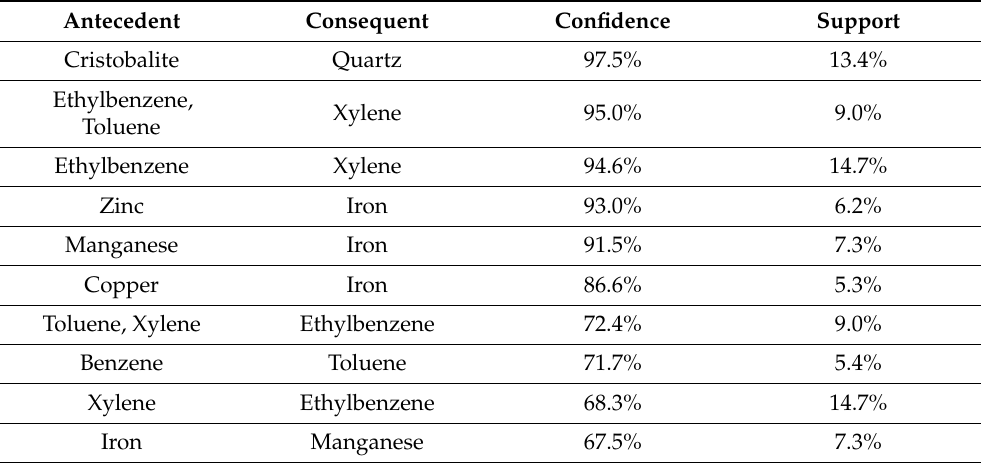
Table 4. List of the ten rules with the highest level of confidence (minimum support of 5%). Antecedent Consequent Confidence Support Cristobalite Quartz